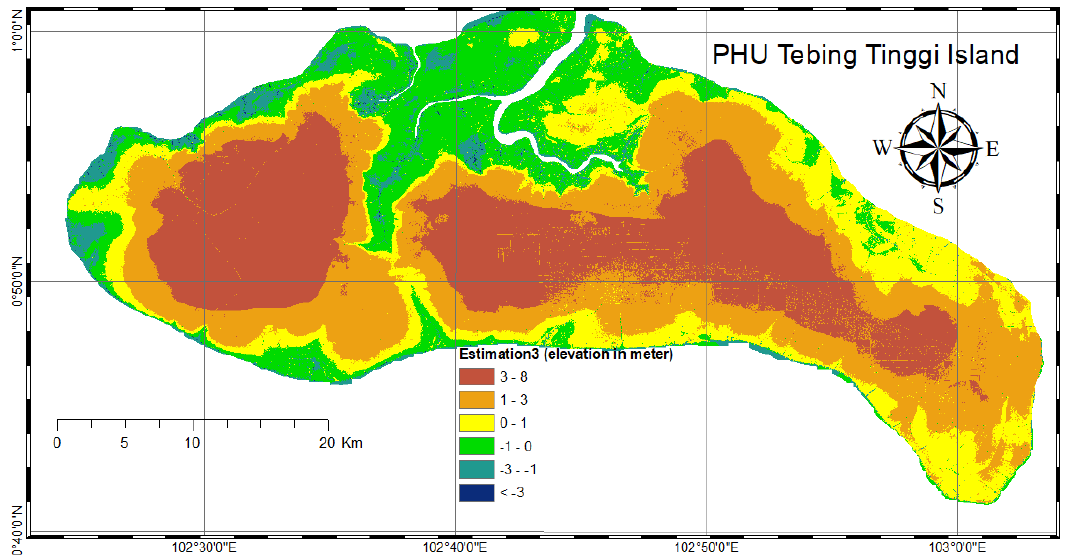
Figure 6. Estimation results of the mineral soil elevation after eliminating four insignificant parameters and removing outliers. Note: the elevation is above the local MSL.